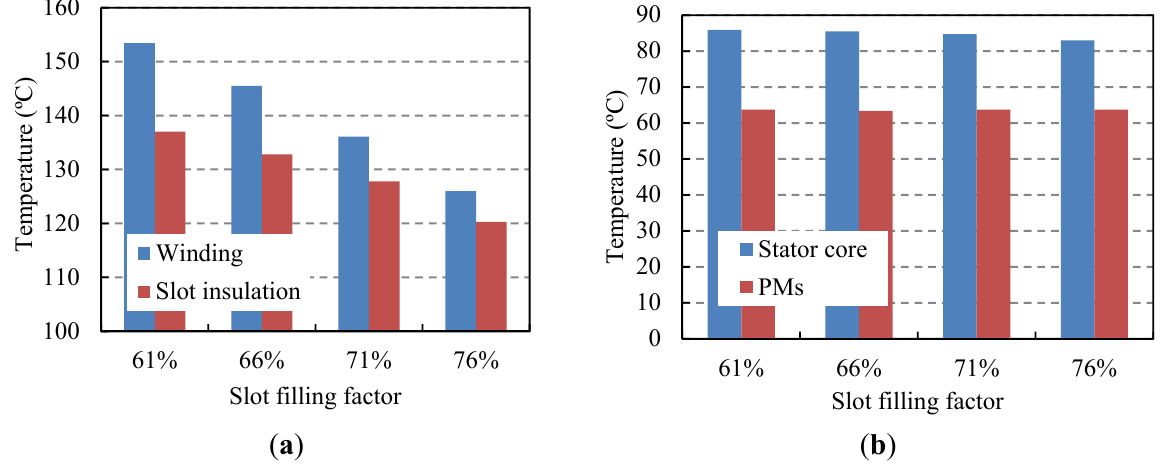
Figure 16. The maximum temperatures of different parts vs. slot filling factor (Case A): ( a ) winding and slot insulation; ( b ) stator core and